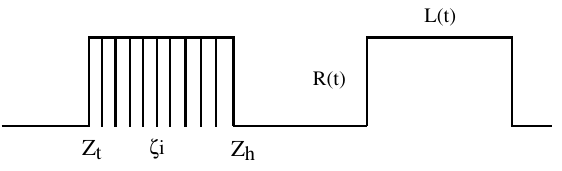
FIG. 3. Electron beam longitudinal profile and slicing proce- dure adopted in HOMDYN . The bunch shape is assumed cylin- drical with length L and radius R . The longitudinal coordinate spanning from the bunch tail of the i th slice is indicated with 0 i Z to the bunch head Z t h